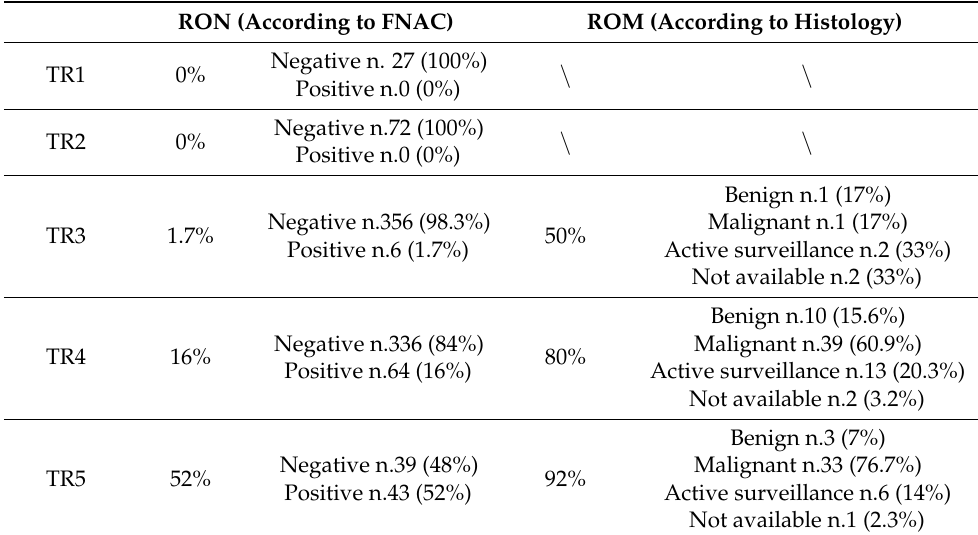
Table 2. RON and ROM according to ACR TI-RADS